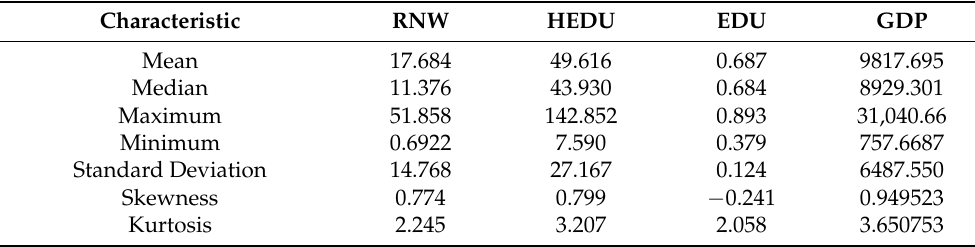
Table 3. Descriptive statistics for variables.